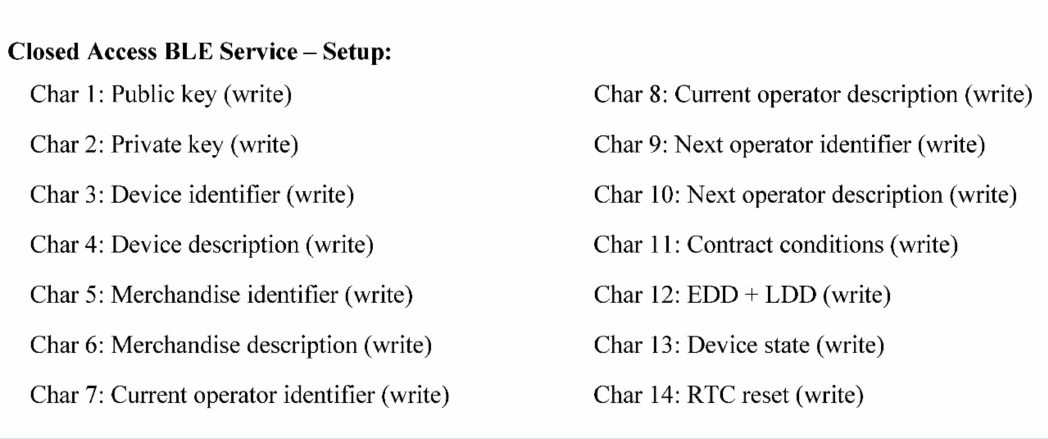
Figure 4. Closed Access BLE